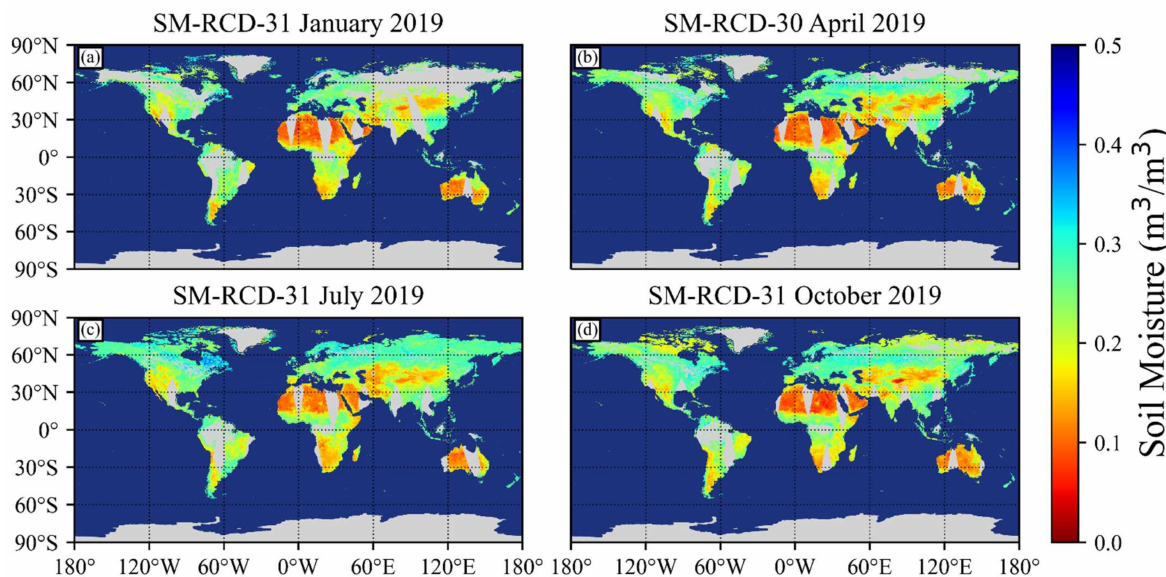
Figure 6. Global soil moisture maps retrieved based on RCD on: ( a ) 31 January; ( b ) 30 April; ( c ) 31 July; and ( d ) 31 October